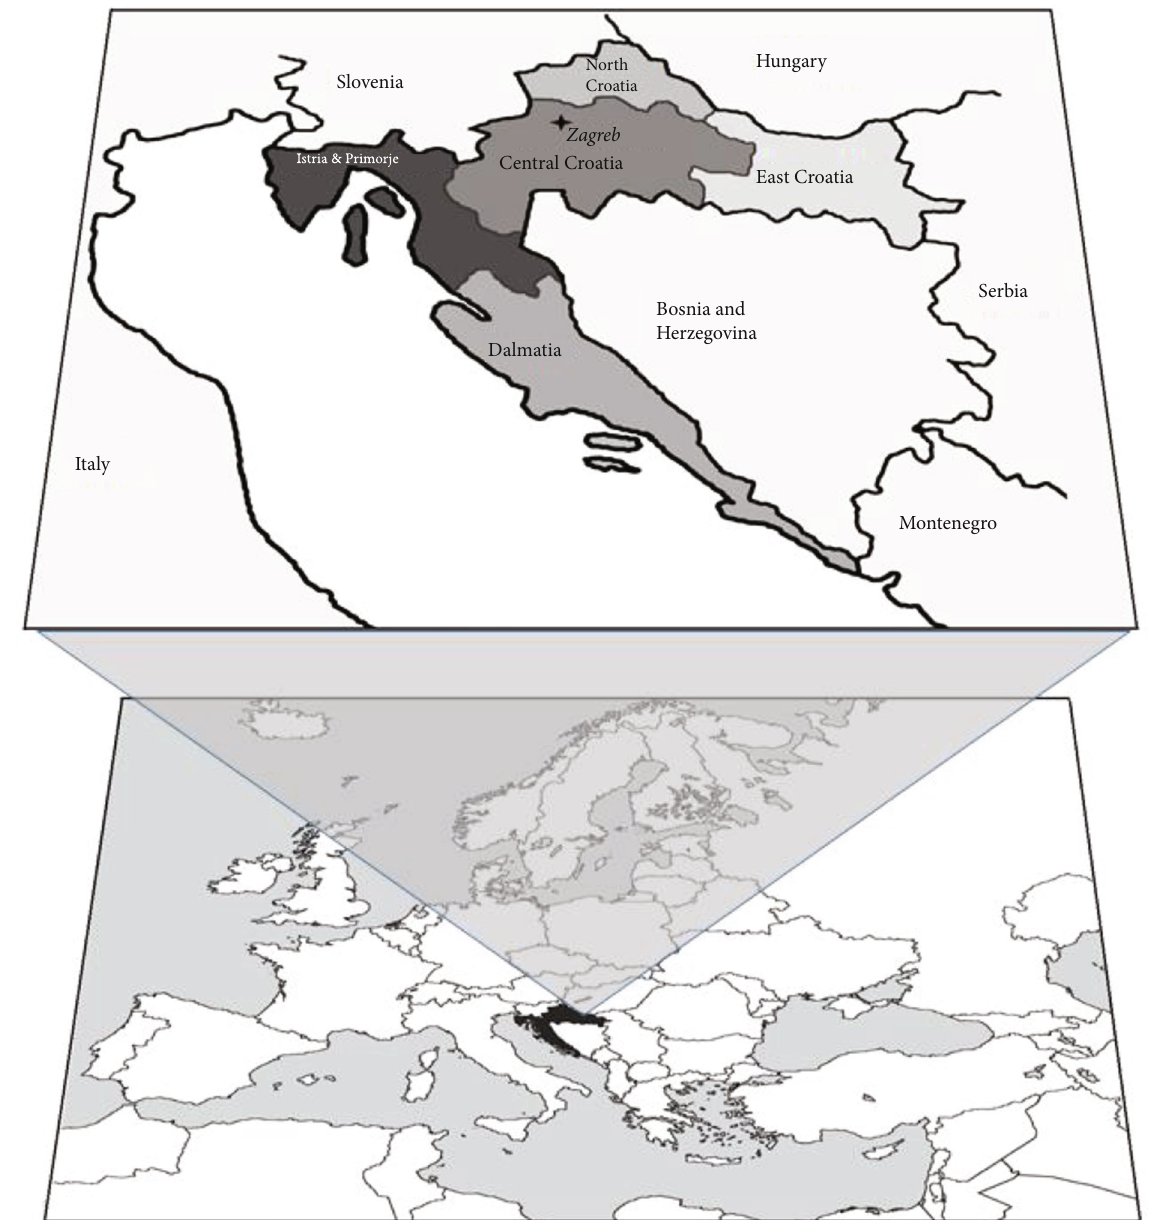
Figure 1: Map of Europe and Croatia. Legend: Central Croatia region varies greatly in population density, as it includes areas with the highest population density (Zagreb, Croatia ’ s capital and surroundings) but also the mountainous areas of Gorski Kotar, Lika, which represent the least populated area in Croatia; East Croatia — the lowland area of the Pannonian Plain, bordered by Croatia ’ s largest rivers, Sava, Drava, and Danube; North Croatia — a small, moderately populated, hilly region on the northernmost border of Croatia; Istria & Primorje includes Istria, the narrow Kvarner region, and nearby islands; Dalmatia — Mediterranean region, with three distinguishable parallel belts: the islands, the coast, and the